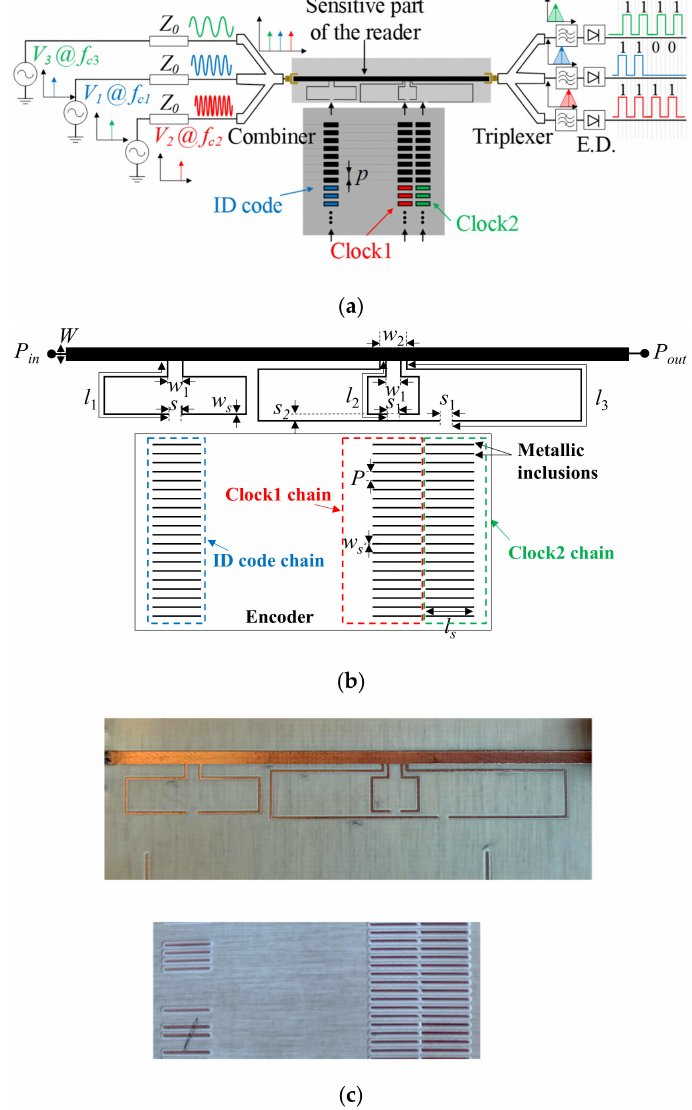
Figure 5. ( a ) Sketch of the absolute electromagnetic encoder system based on linear strips with motion direction detection capability; ( b ) Topology of the reader and encoder; ( c ) photograph of the Figure 1. 81, l 1 = 24.39, l 2 = 12.33, l 3 = 48.60, w 1 = 1.80, w 2 = 3.40, s 1 = 1.60, s 2 = 0.90, P = 1.20, w s = 0.20 and l s = 6.40. The considered substrate for the reader is the Rogers RO4003C with dielectric constant ε r = 3.55, thickness h = 0.81 mm, and loss tangent tan δ = 0.0021. For the encoder, the only difference is the thickness, h = 0.204 mm. Reprinted with permission from [32]. Copyright 2021